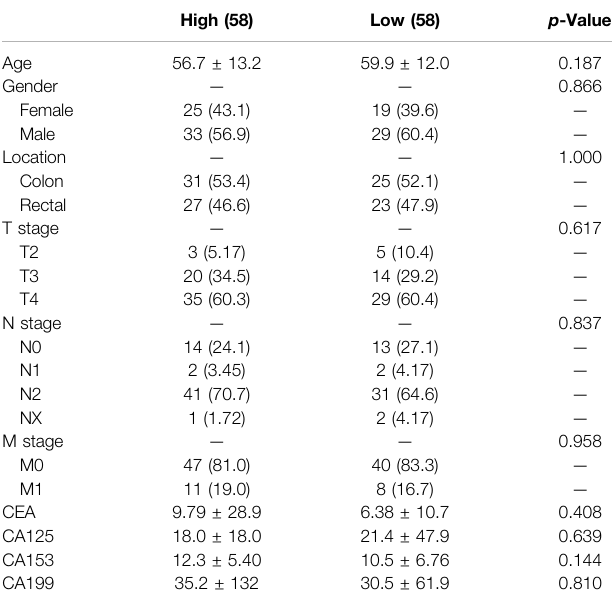
TABLE 2 | Association of blood levels of HMMR with the clinical parameters.